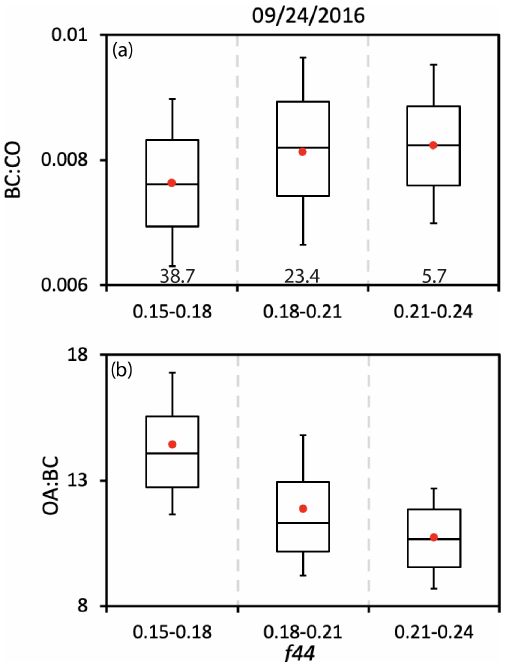
Figure 13. (a) BC /(cid:49) CO ratios (dimensionless) as a function of f 44 for the 24 September 2016 flight. The number of minutes con- tributing to each f 44 bin is stated at the bottom of the panel. Panel (b) is the same for OA : BC. Whiskers represent the 10th and 90th percentiles, and boxes illustrate the 75th and 25th percentiles, with a line indicating the median and a red filled circle the mean. OA > 20µgm − 3